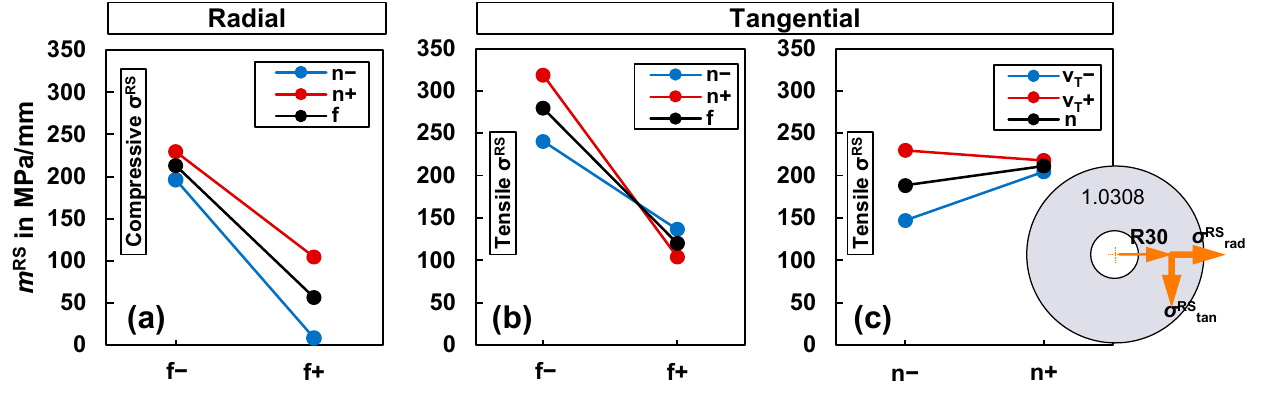
Figure 8. Effects and interactions, determined with design of experiments methods (DoE), of the feed rate f , rotation speed n and quenching v t on the gradients of the residual stress curves m RS in the tangential and radial direction.